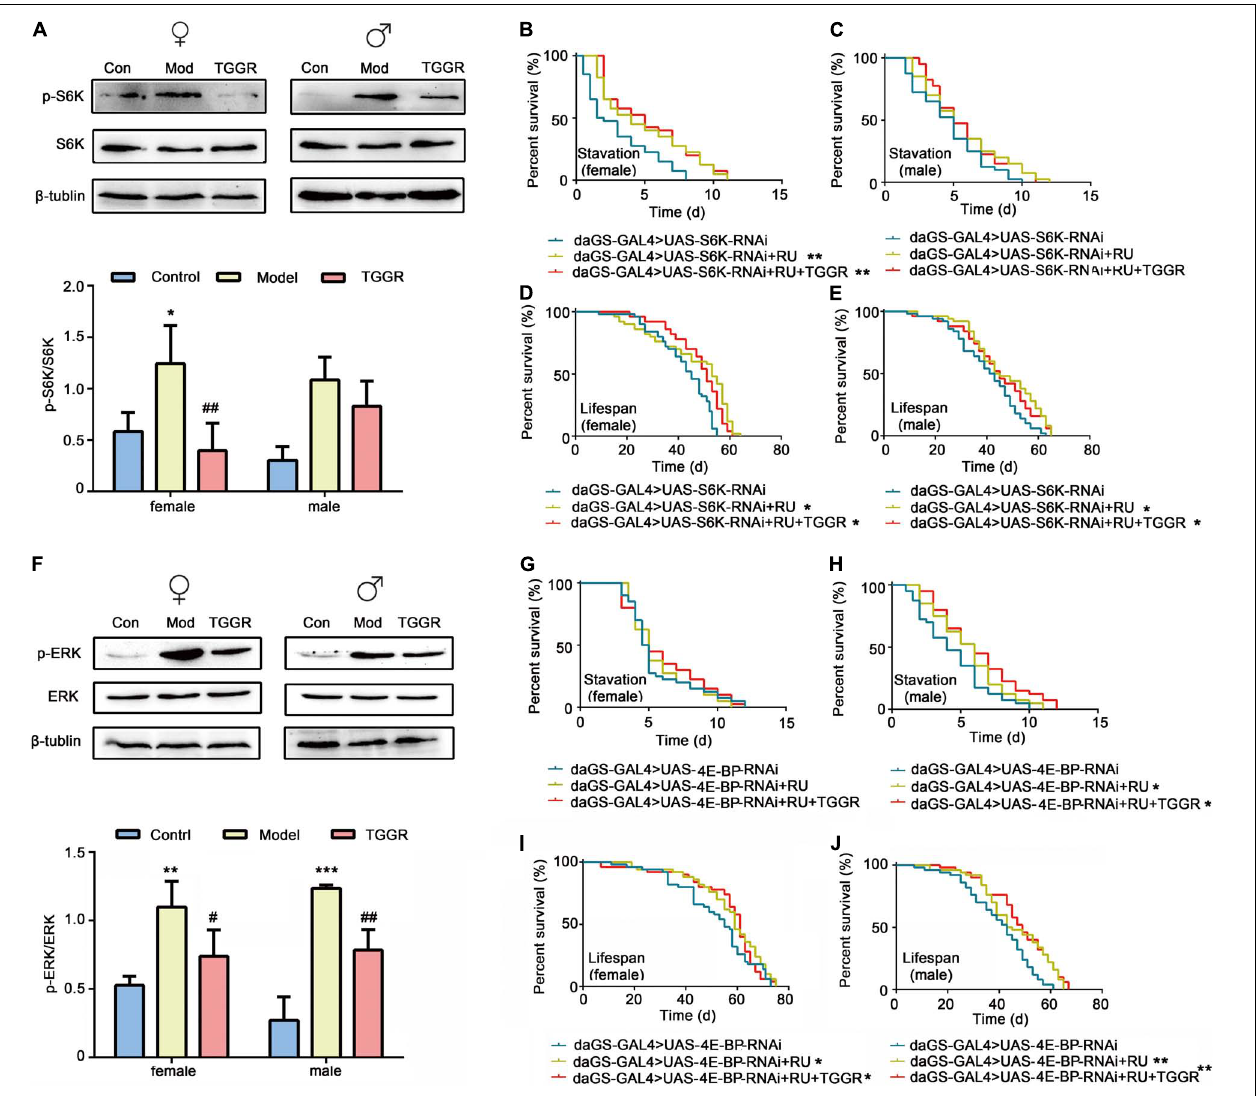
FIGURE 9 | TGGR regulates TOR and MAPK pathways by affecting the major components, S6K, 4E-BP and ERK. (A) Phosphorylation levels of S6K were analyzed by western blotting ( N = 50 flies per condition, two-tailed unpaired t -test). (B,C) Starvation resistance in S6K-knockdown flies. (D,E) Lifespan changes in S6K knockdown flies [ N = 50 flies per condition, Log-rank (Mantel-Cox) test]. (F) Western blot analysis of ERK phosphorylation levels ( N = 50 flies per condition, two-tailed unpaired t -test). (G,H) 4E-BP downregulates starvation resistance in flies. (I,J) Lifespan changes in 4E-BP knockdown flies [ N = 50 flies per condition, Log-rank (Mantel-Cox) test]. “Control” was 7-day-old flies, “Model” was 40-day-old flies, and “TGGR” was 40-day-old flies with TGGR (5 mg/mL) treatment. * p < 0.05, ** p < 0.01, *** p < 0.001 vs. the control; # p < 0.05, ## p < 0.01 vs. the